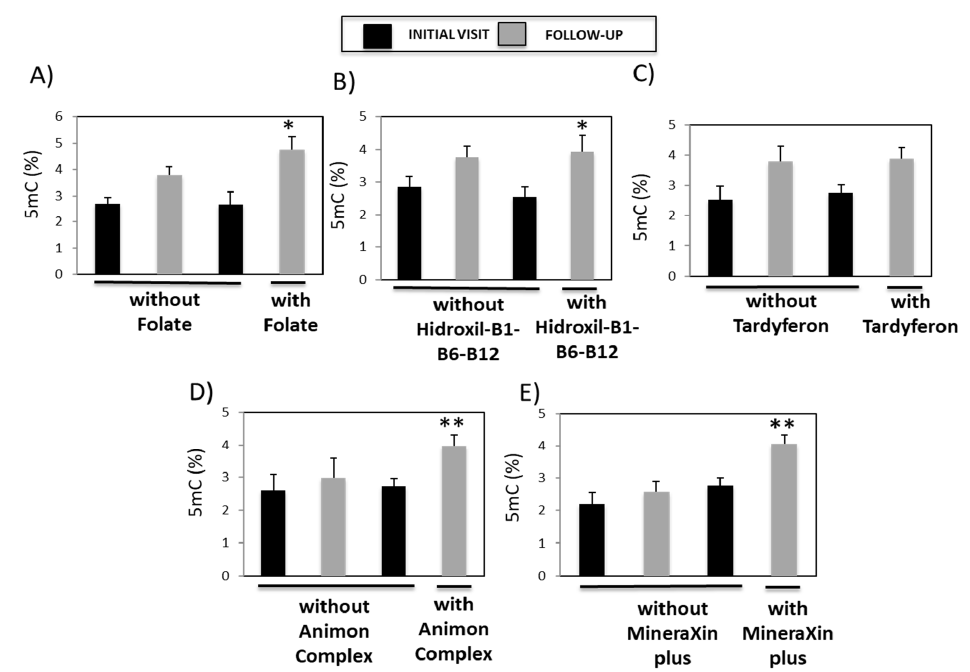
Figure 8. The relationship between vitamins, iron supplements, and nutraceutical bioproducts and global DNA methylation in patient serum samples. 5mC levels were compared in patients whose 5mC levels were higher during the follow ‐ up than during the initial visit and who were, or were not, treated with ( A ) folate, ( B ) Hidroxil ‐ B1 ‐ B6 ‐ B12, ( C ) Tardyferon, ( D ) Animon Complex ® , and ( E ) MineraXin Plus TM . Data are presented as the mean ± S.E.M; one way ANOVA and Bonferroni post hoc test (* p < 0.05; ** p < 0.01). 5mC, 5 ‐ methylcytosine. Many patients in Group A were diagnosed with neuropsychiatric, cerebrovascular, and neurodegenerative disorders. Therefore, we next analyzed whether there were differ ‐ ences in the levels of global DNA methylation in those patients with neurological disor ‐ ders between the initial ‐ and follow ‐ up visits in the presence of and absence of treatment with conventional drugs (Actron, Tryptizol, Deprax, Diazepam, Varson, and Somazine) and with nutraceutical bioproducts (AtreMorine and NeoBrainine). Patients who were or were not treated with Actron exhibited higher 5mC values during the follow ‐ up ‐ ( p = 0.01) than during the initial visits ( p = 0.014) (Figure 9A). However, in patients who were not treated with Tryptizol ( p < 0.001) (Figure 9B), Deprax ( p = 0.0049) (Figure 9C), Diazepam ( p = 0.0069) (Figure 9D), Varson ( p = 0.009) (Figure 9E), and Somazine ( p = 0.031) (Figure